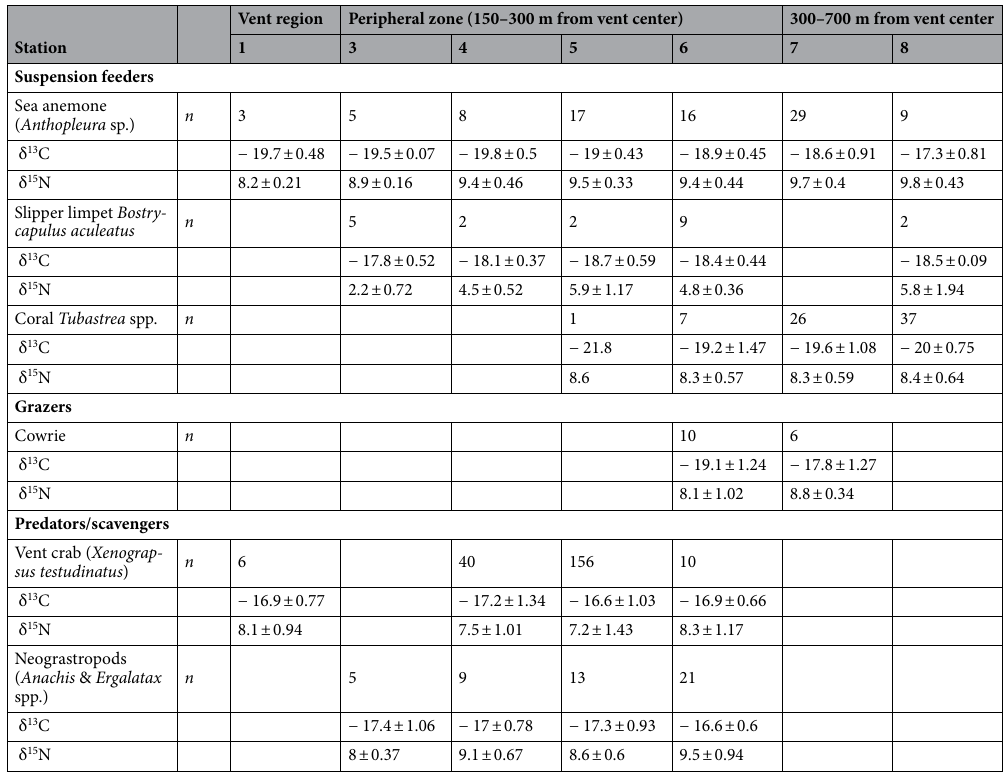
Table 2. δ 13 C and δ 15 N values (mean ± SD) of the benthic consumers collected from the Kueishan Island shallow-water vents. n , number of samples. Variation among consumers (stations pooled) Kruskal Wallis tests: (δ 13 C: H = 236.47, df = 4, P < 0.001; δ 15 N: H = 25.866, df = 4, P < 0.001). Dunn’s test: δ 13 C: sea anemone = cowrie = slipper limpet > vent crabs = neogastropods; δ 15 N: sea anemone = neogastropds > vent crab = corals = cowries > slipper limpet. Variation among stations within each consumer. vent crabs: Kruskal–Wallis test: H = 7.628, df = 3, p > 0.05. sea anemones: ANOVA: F 6,80 = 13.069, p > 0.05; neogastropods: ANOVA: δ 13 C: F 3,44 = 2.66, p < 0.05; SNK tests: 8 > 5 = 6 = 7 > 1 = 3 = 4; δ 15 N: F 3,44 = 8.576, p < 0.05; SNK tests: